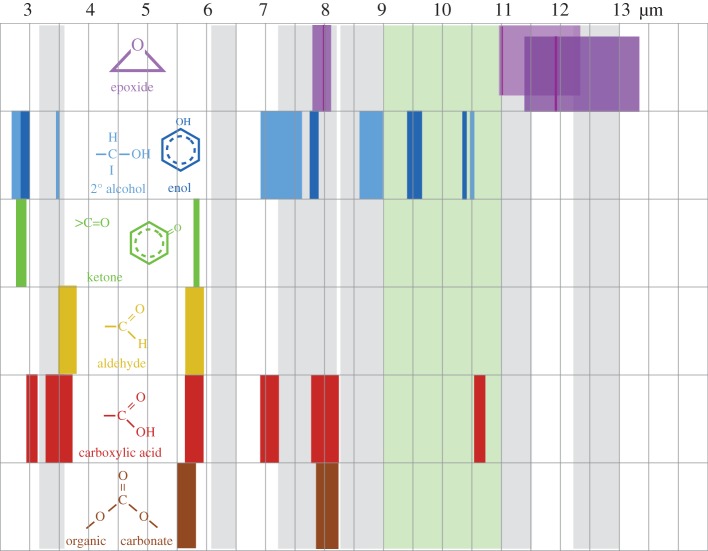
Schematic view of the typical IR wavelength regions (N.B., not the band widths) where the peaks of the given functional group absorption bands can be found. The wavelength in micrometres is shown on the upper scale. The grey bands indicate the approximate widths of the IR emission bands observed in the low-density, diffuse ISM and the green band the approximate width of the amorphous silicate 9.7 μm absorption band. For the epoxide, the widely variable positions of the two longer wavelength bands have been separated for clarity and the positions of the bands of a particular epoxide material are indicated by the thin darker lines.